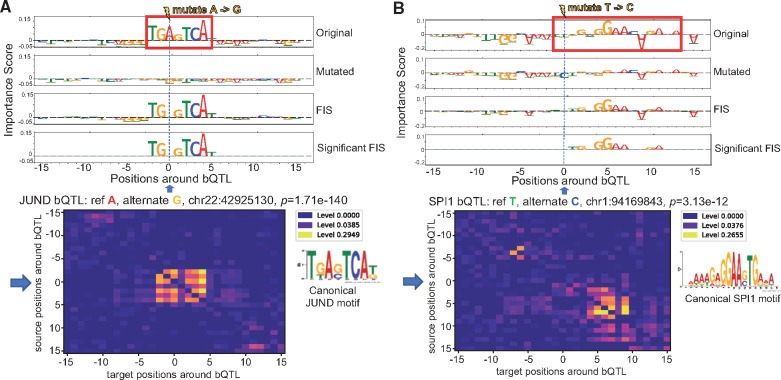
Examples of NFKB bQTL (A) and JUND bQTL (B) exhibiting strong feature interaction scores (FIS) with nucleotides in an overlapping motif and flanking motif respectively. Row 1 and 2 in both panels are the feature importance scores of each nucleotide around the bQTL for the reference and alternate allele respectively. Row 3 in both panels show the feature interaction scores (FIS) indicating the change in importance when the reference allele is mutated to the alternate allele. Row 4 shows only statistically significant interactions. Row 5 shows the deep feature interaction map as a heatmap